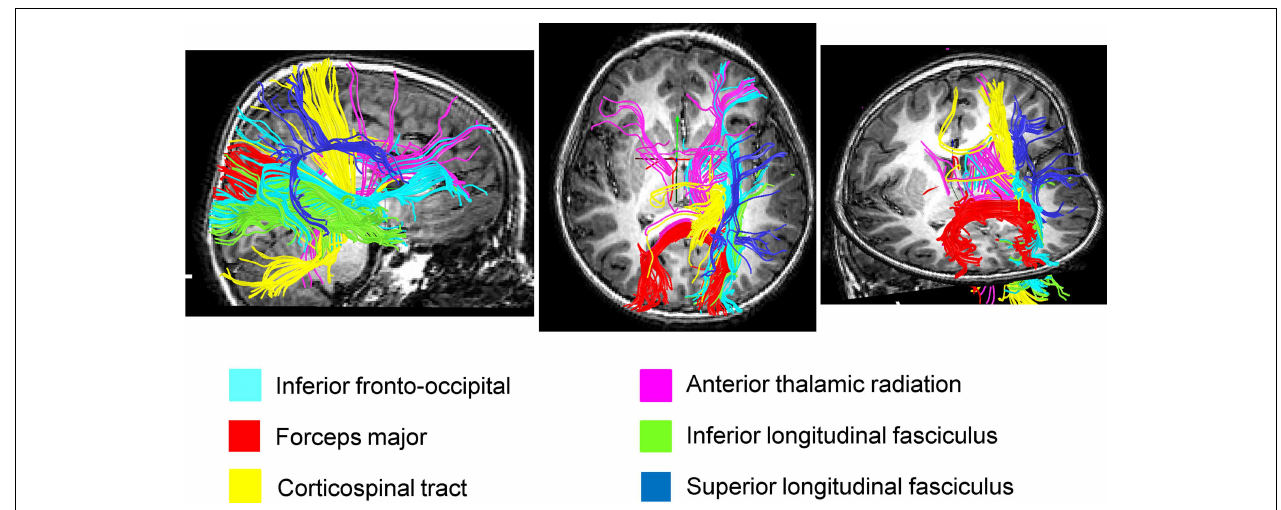
FIGURE 4 | Streamlined reconstruction of white matter pathways passing through the right temporal-parietal regions where children with DD showed signifi cant white matter volumetric defi cits, compared to TD children. Data is from a representative TD child. Tracts labels are obtained using the probabilistic JHU white matter tractography atlas.